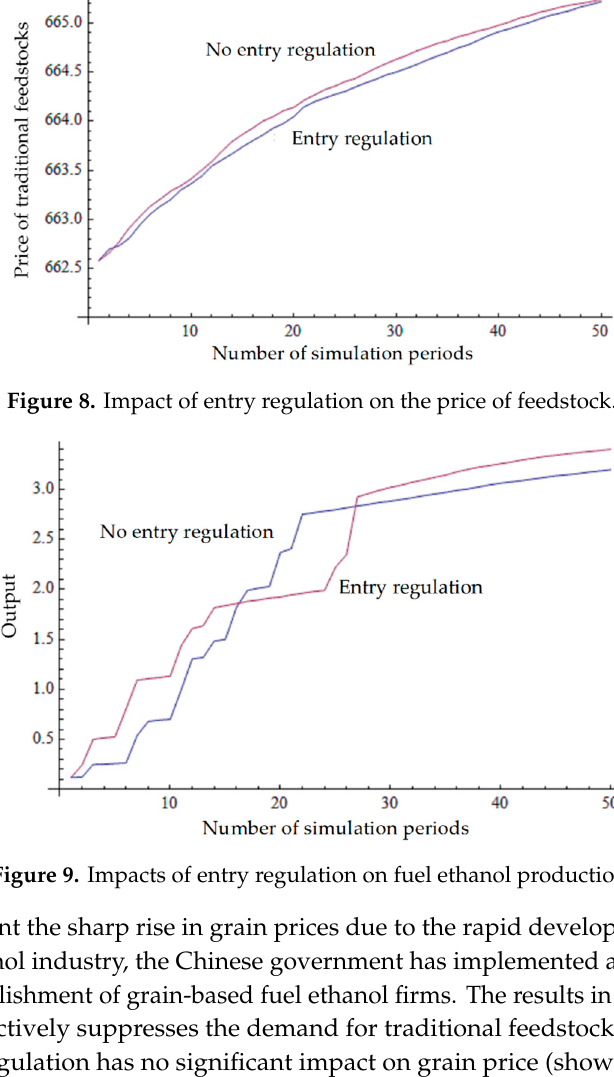
Figure 7. Impact of entry regulation on the demand for feedstock.